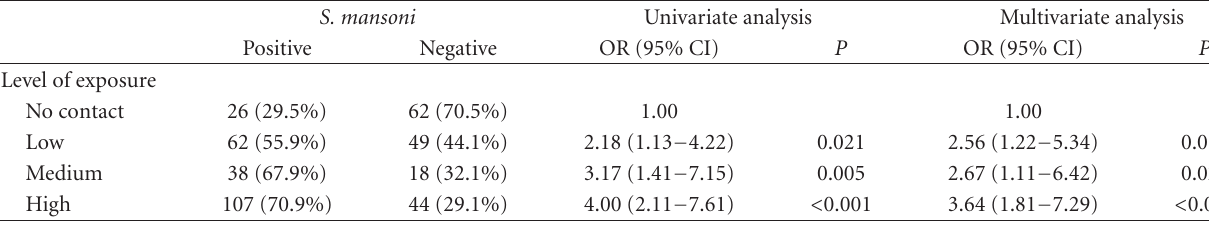
Table 1: Frequency of S. mansoni infection according to the level of exposure.